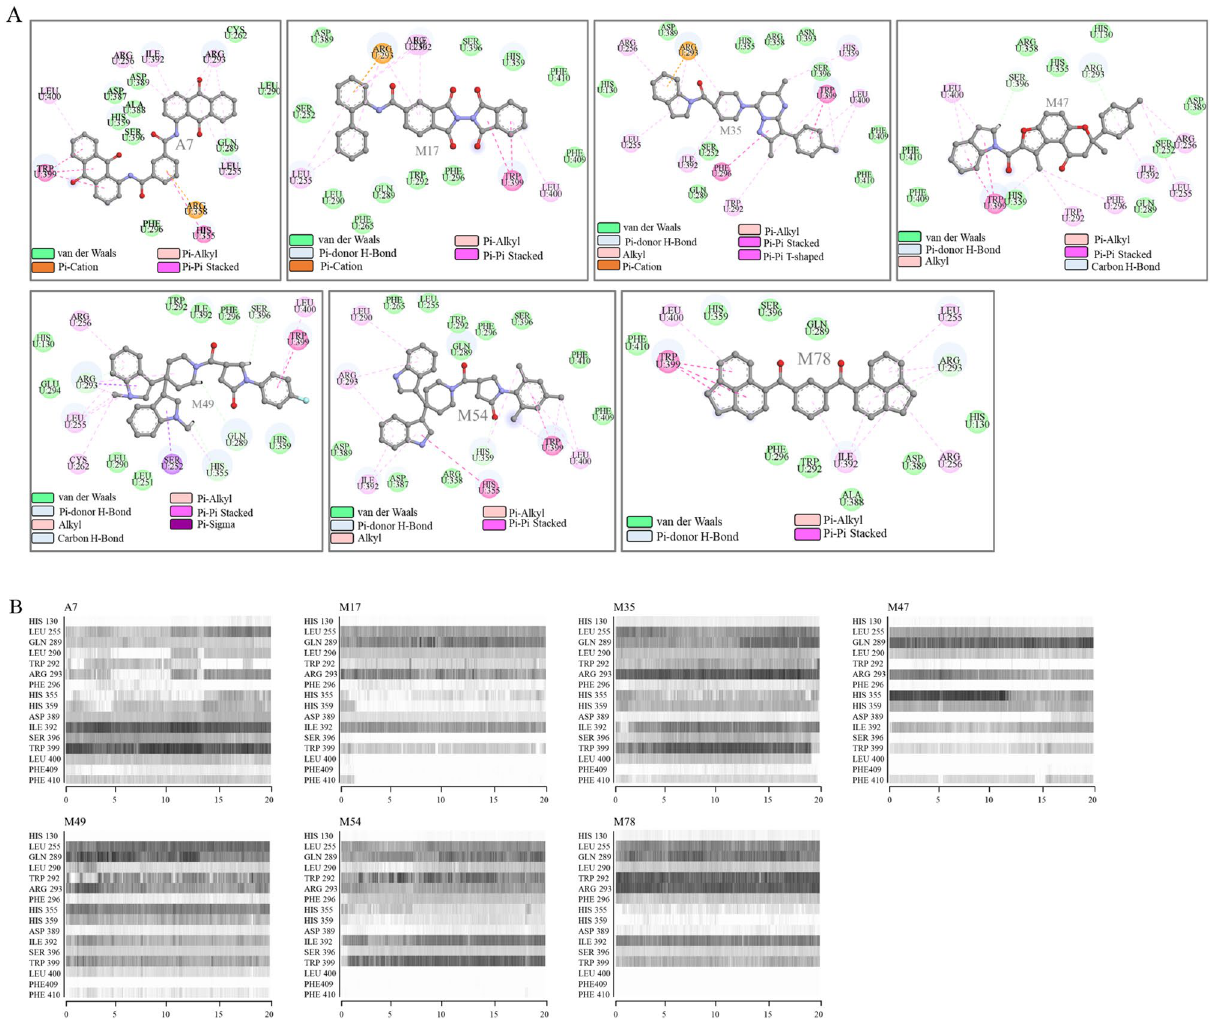
Figure 5. Binding mode of molecules on CRY1 and analysis of molecular dynamic simulations of CRY1- molecule complexes. ( A ) Docked conformation of molecules was analyzed and 2D interaction map was generated using Discovery Studio Visualizer. Type of interactions was given in color-coded format. ( B ) Interaction maps of molecules with CRY1 through 20 ns MD simulation were generated using VMD timeline applet. It has been evaluated as interaction if molecule and amino acid residues get 5 Å or closer and shown with a black